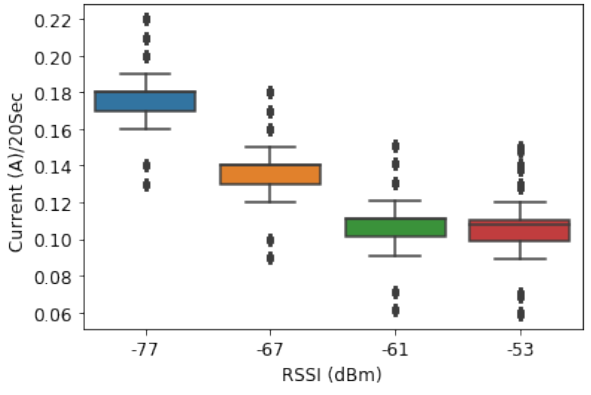
Figure 12. Current consumption vs. RSSI in 20-s time stamps.